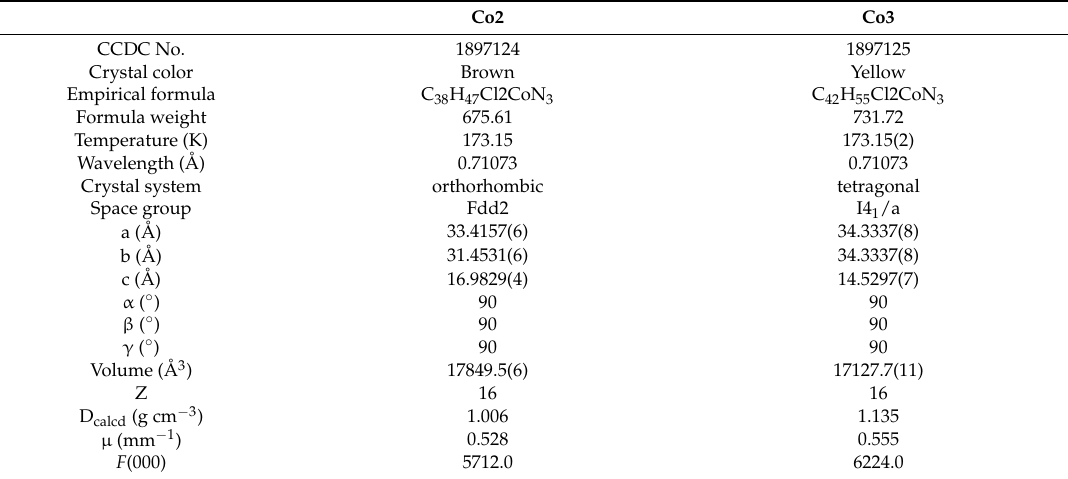
Table 4. Crystal data and structure refinement for Co2 and Co3